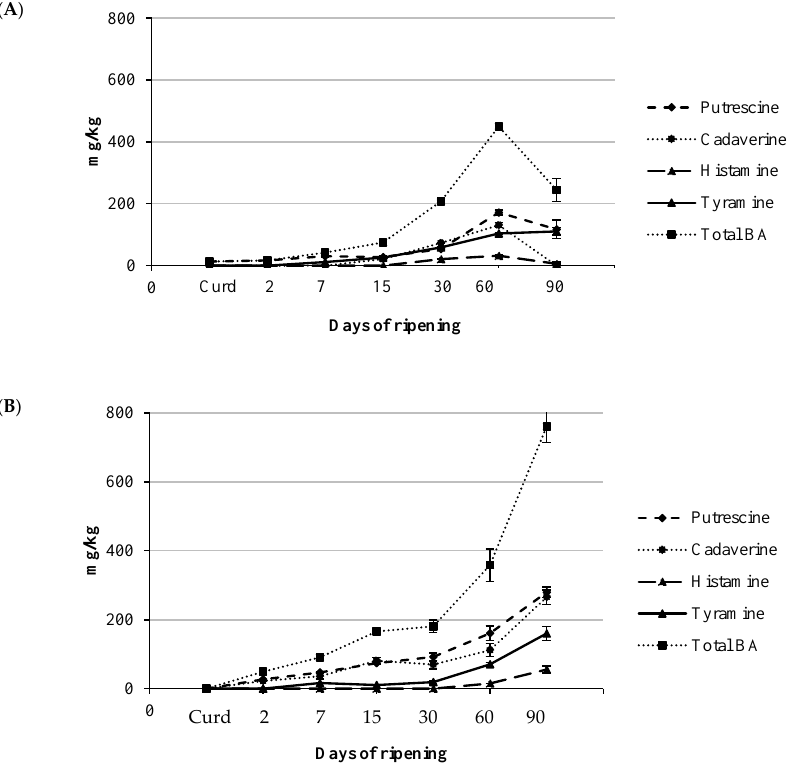
Figure 2. Biogenic amines content (mg/kg) during the ripening in Cheese A ( A ) and Cheese B ( B ). BA, biogenic amine.